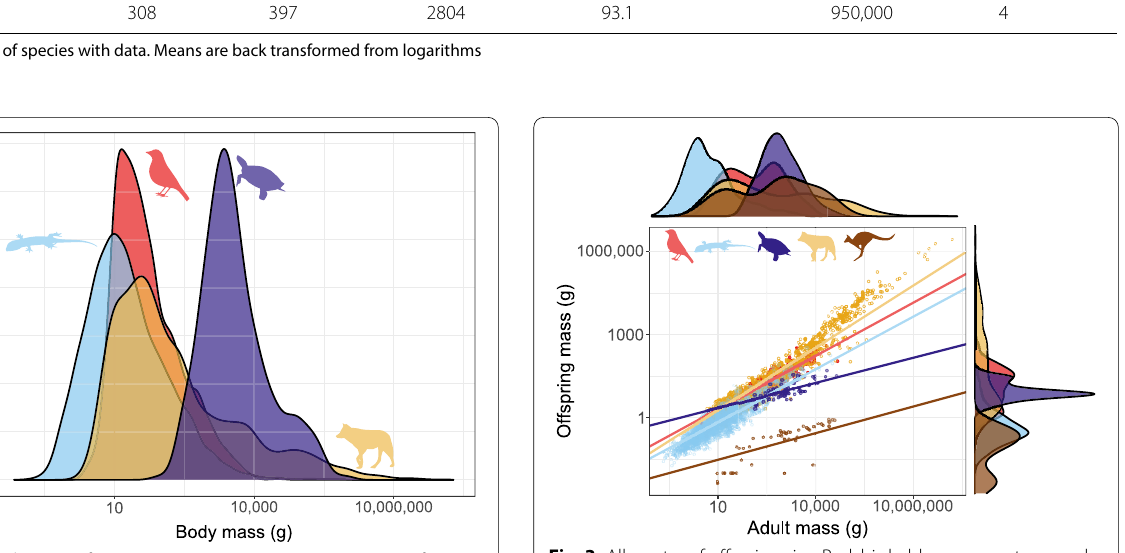
Fig. 2 Body mass of amniotes. Masses (in grams) are maxima for ectotherms and means for endotherms. Red: birds, blue: squamates, purple: turtles and yellow: mammals (both placentals and marsupials). Note that the x axis is log 10 scaled